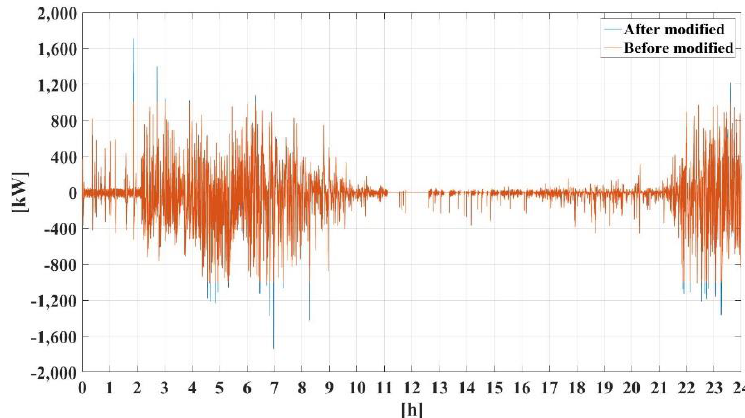
Figure 24. Field test and simulation results: output powers of ESS (zoomed segment 2).